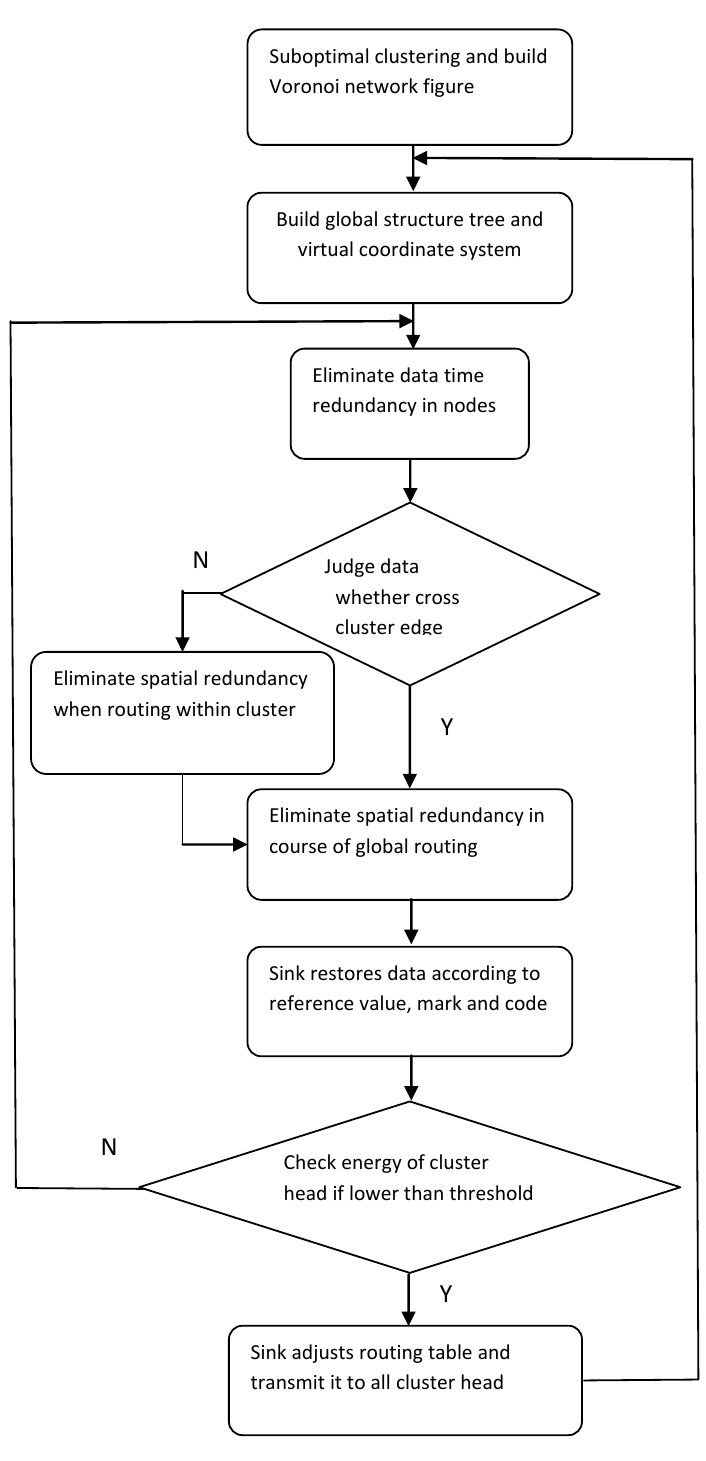
Figure 1. Flow chart of the SC-LVLR